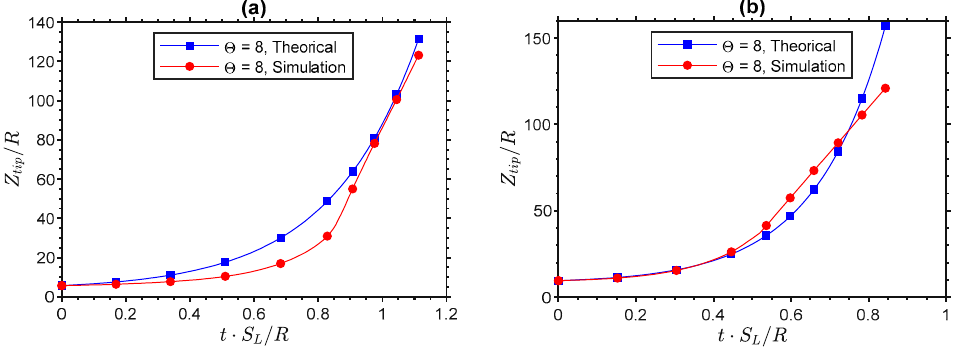
Figure 10. The scaled flame tip position Z tip / R versus the scaled time τ = tS L / R for burning in the channels of half-width R = 24 L f with the blockage ratios α = 1/2 ( a ) and α = 2/3 ( b ).